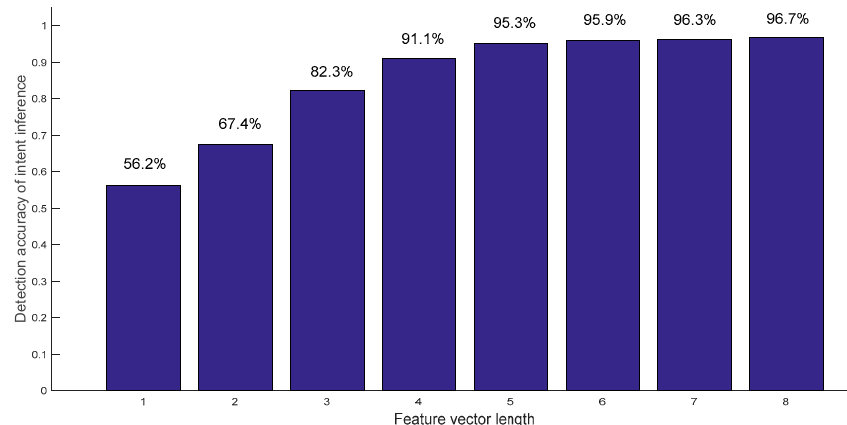
Figure 5. Relationship between the length of feature vector M and the accuracy of intent estimation. The accuracy grows with the length while the growth rate is